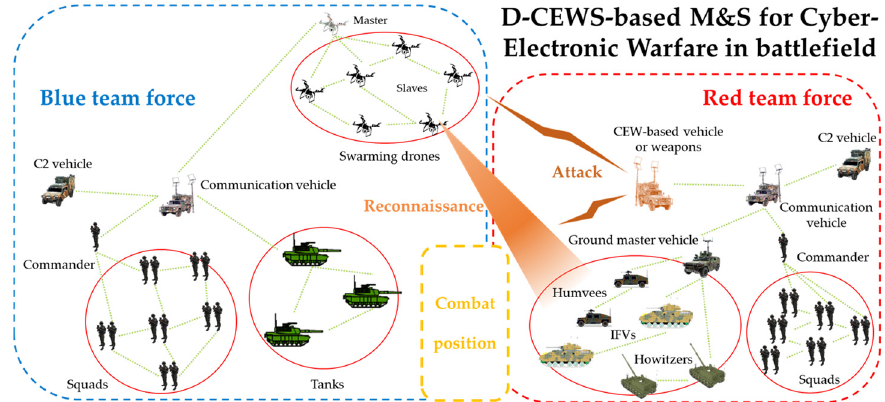
Figure 14. Main overview of D-CEWS (DEVS-based cyber-electronic warfare)-based modeling and simulation scenario for cyber-electronic warfare with reconnaissance report in a swarming communication drones maneuvering system.